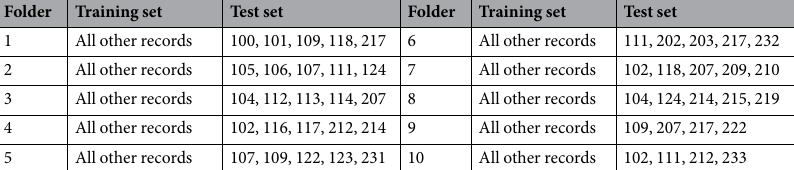
Table 3. Record division of the training and test sets for the record-based cross validation